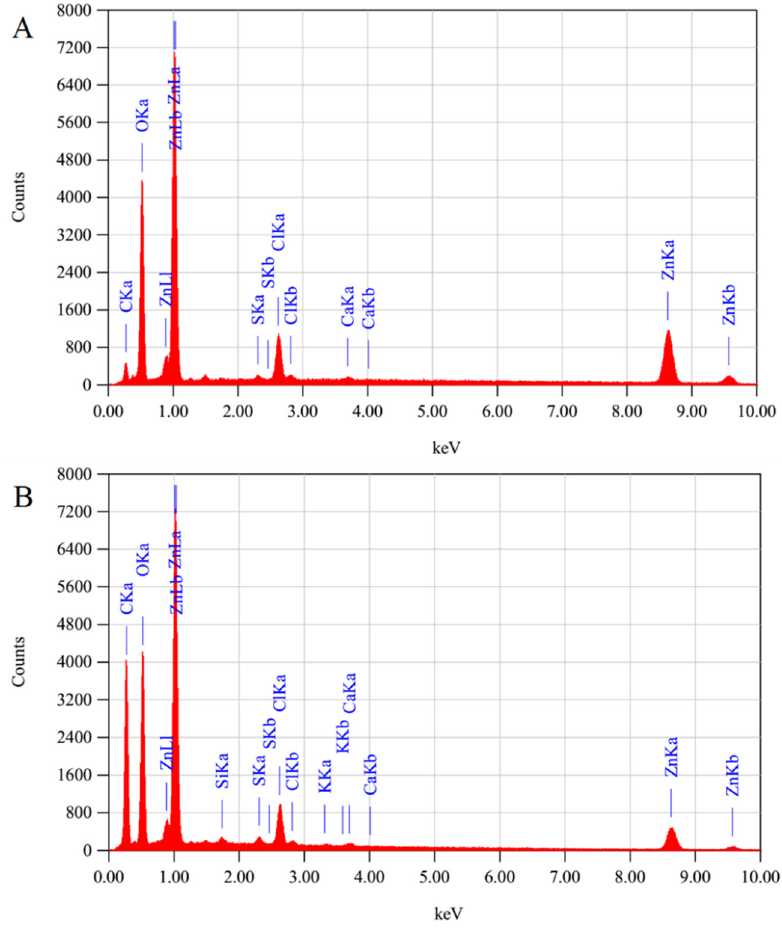
Figure 4. EDX spectra of ( A ) ZnO − NPs, along with the EDX spectra of ( B ) CNTs/ZnO composite.